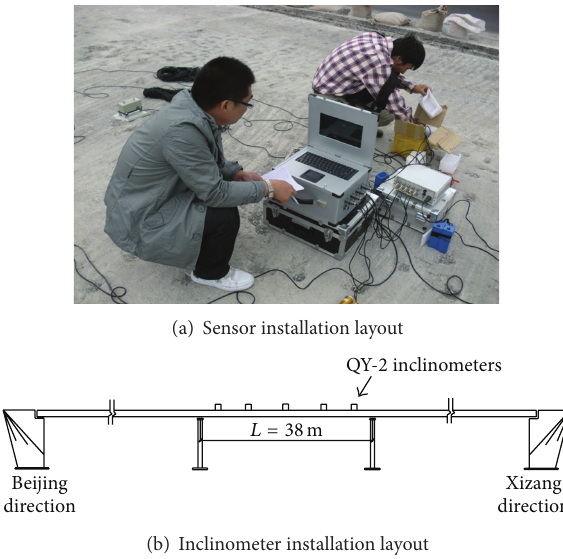
Figure 1: Bridge vibration measurement and test chart.